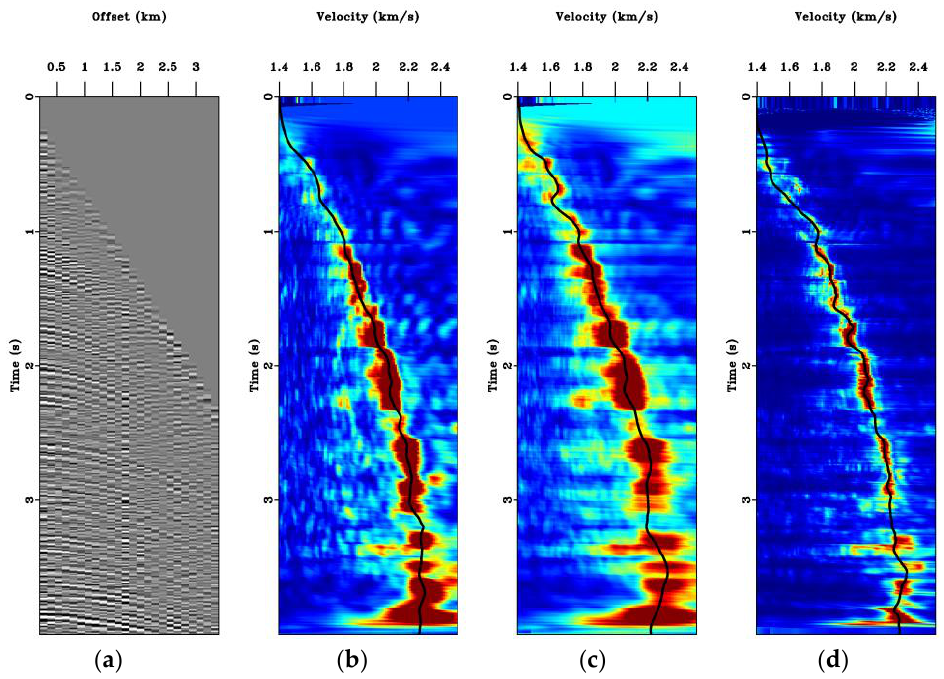
Figure 7. 2-D field data and the corresponding semblance spectra, where the solid curves in the semblance represent the picked velocities. From left to right: ( a ) uncorrected CMP gather on which all methods of semblance were applied, ( b ) conventional semblance, ( c ) AB semblance, and ( d ) PCA- weighted semblance.